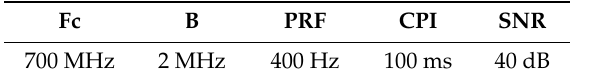
Table 2. System parameters in the real measured data experiment.